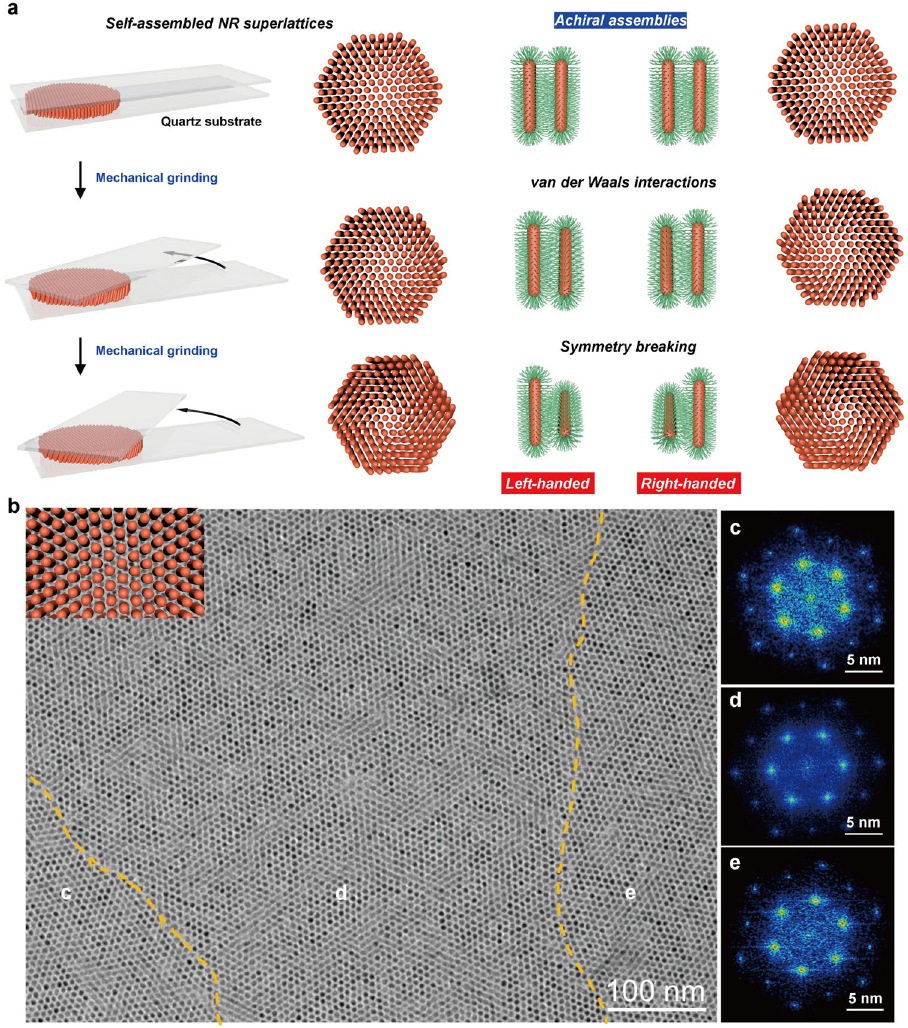
Fig. 1 | Design principle for exerting chirality of NR assemblies mechanically. a Schematic illustration of the chirality generation in self-assembled NR super- lattices through a press-and-rotate mechanical force. b TEM image of self-